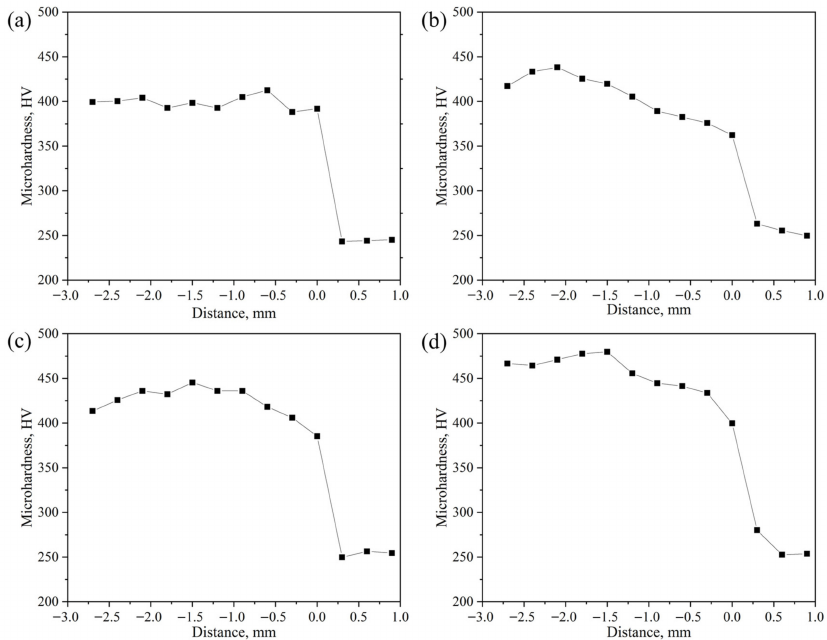
Figure 10. Microhardness distribution of the CILs. ( a ) CIL-1; ( b ) CIL-2; ( c ) CIL-3; ( d )